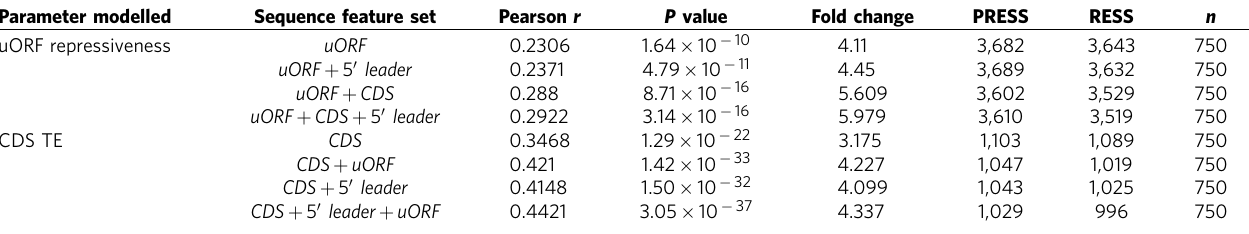
CDS, coding sequence; TE, translation efficiency Summarystatisticsincludesthe linearcorrelationandpredictionerrors(usingthepredictedresidualsum ofsquaresorPRESSstatistic),aswellasthefold changeinuORFrepressivenessobservedovera 95% range in the combined